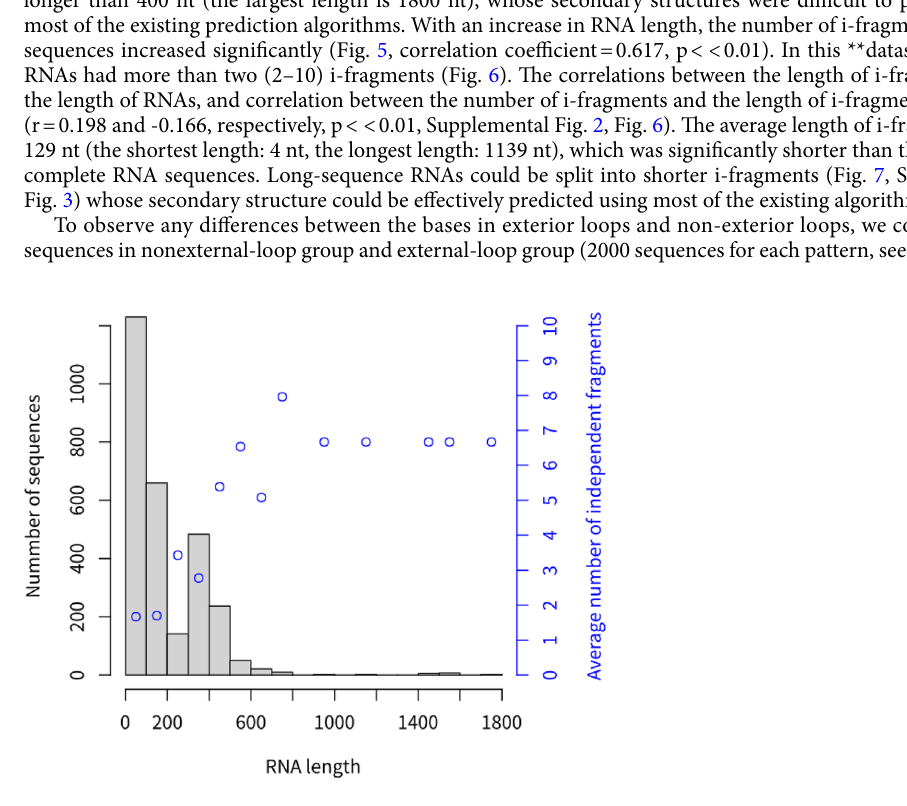
Figure 5. RNA length distribution and the average number of i-fragment of RNAs with different lengths. The black bars correspond to the black y-axis on the left, while the blue dots correspond to the blue y-axis on the right. The employed dataset composed of 2,847 unduplicated RNAs (indicated by red circle in Fig. 2) obtained by duplicated or similar sequence removal from sequences in group two.